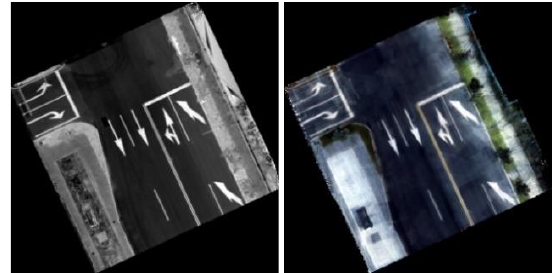
Figure 4. Resulting (Left) Intensity Image and (Right) RGB Image